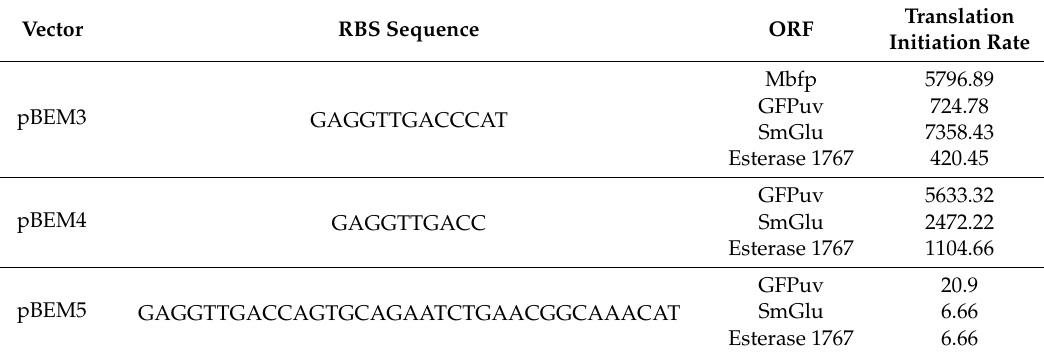
Table 2. Translation initiation rates of foreign proteins in each of the pBEM series